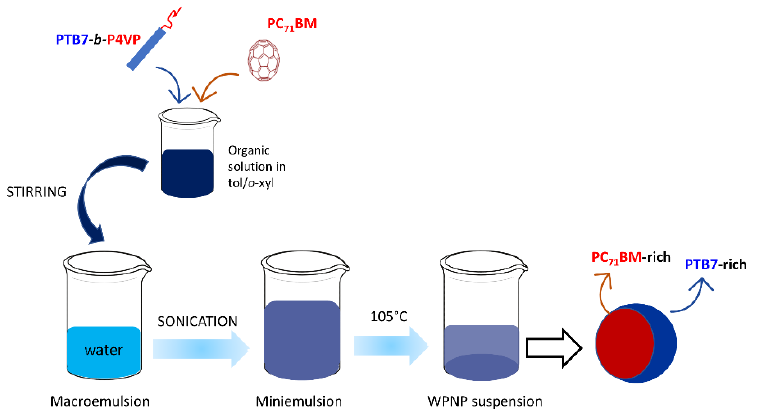
Figure 3. Representative scheme of WPNP aqueous suspension production process through a modi- fied miniemulsion approach and depiction of the Janus-like morphology revealed by TEM